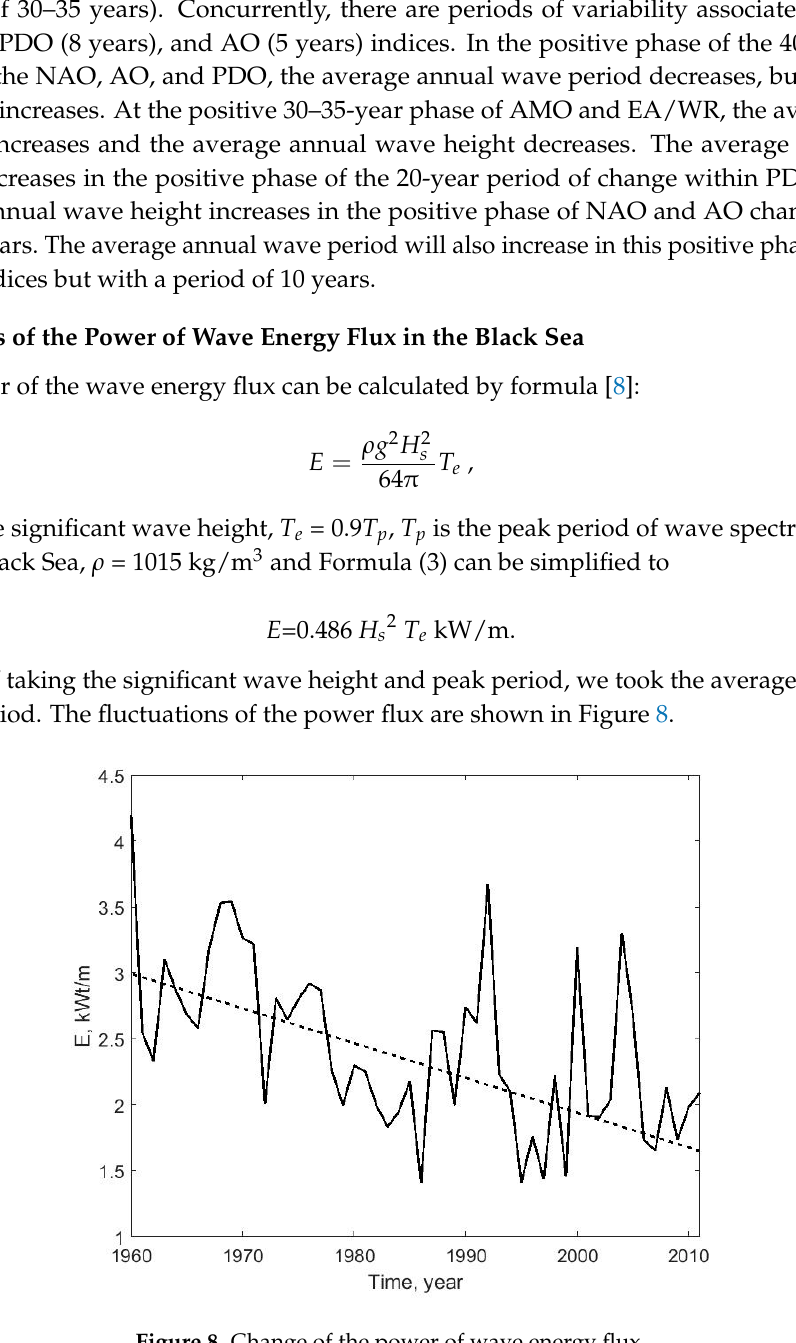
Figure 8. Change of the power of wave energy flux.